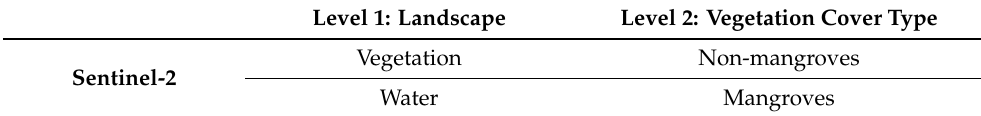
Table 1. Image object hierarchy for the mangrove feature classifications from Sentinel-2.